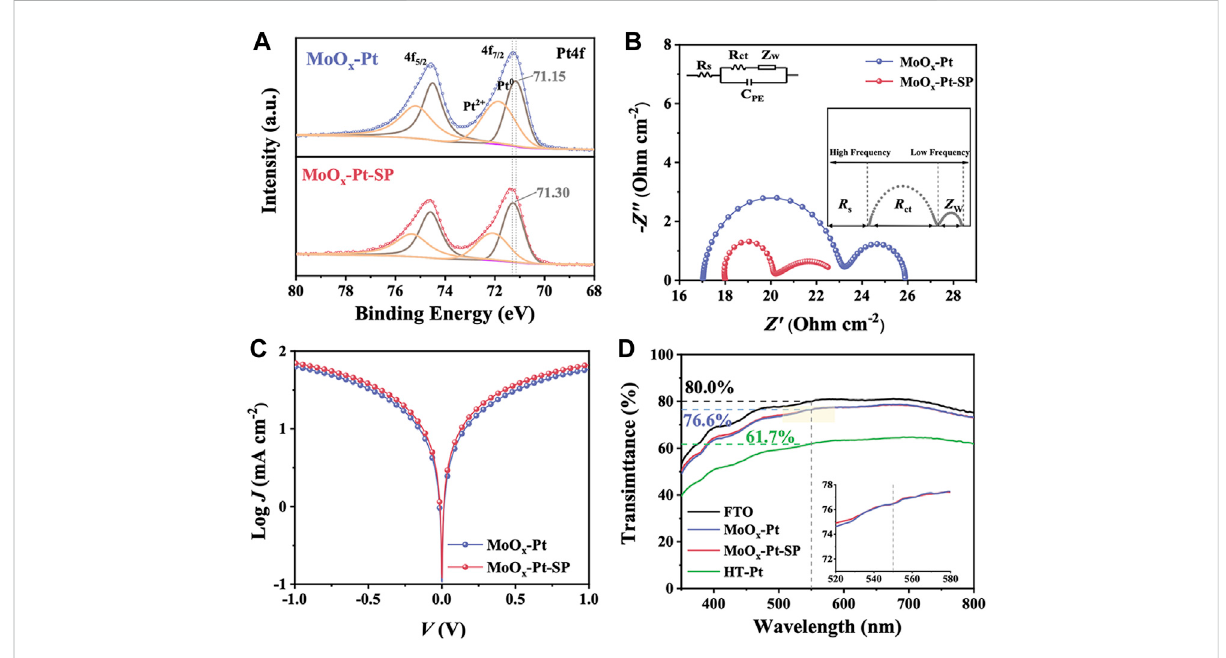
FIGURE 4 Pt4f XPS spectra (A) of MoO x -Pt and MoO x -Pt-SP. Nyquist plots (B) and Tafel polarization curves (C) of MoO x -Pt and MoO x -Pt-SP electrocatalytic electrodes. Transmittance spectra (D) of FTO, MoO x -Pt, MoO x -Pt-SP, and HT-Pt electrocatalytic electrodes.